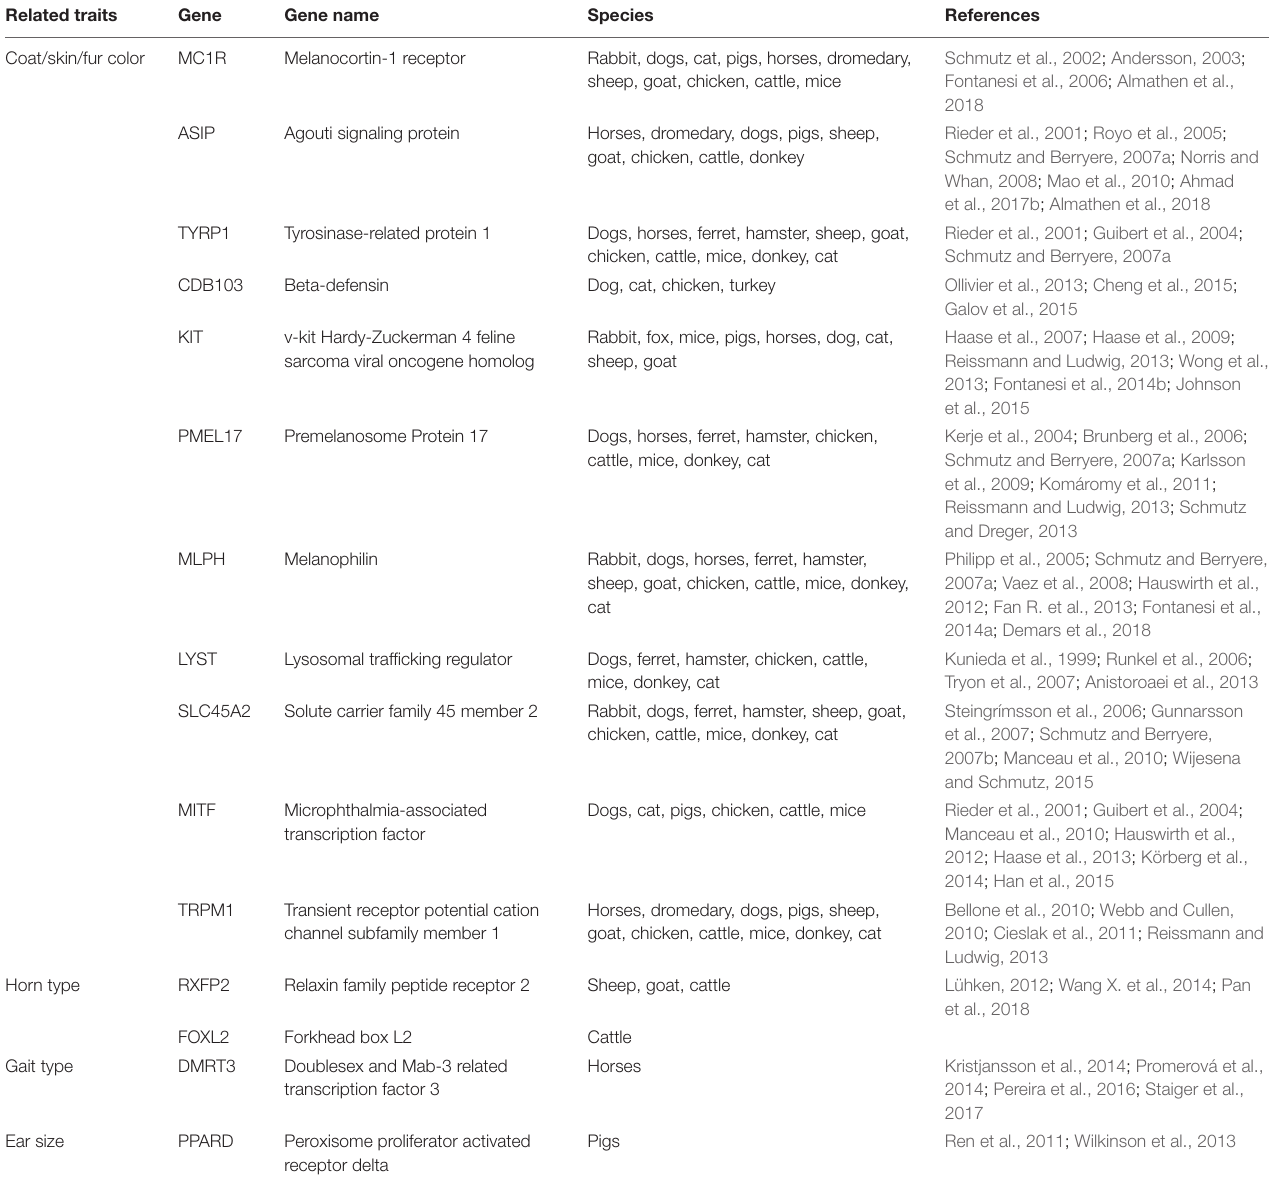
TABLE 1 | Genes involved in domestication phenotypes in